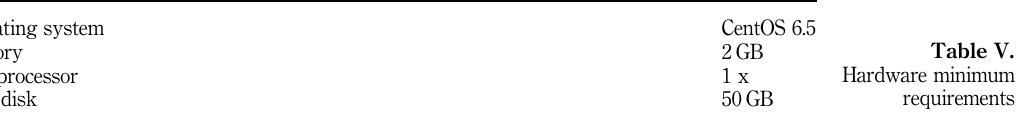
Table V. Hardware